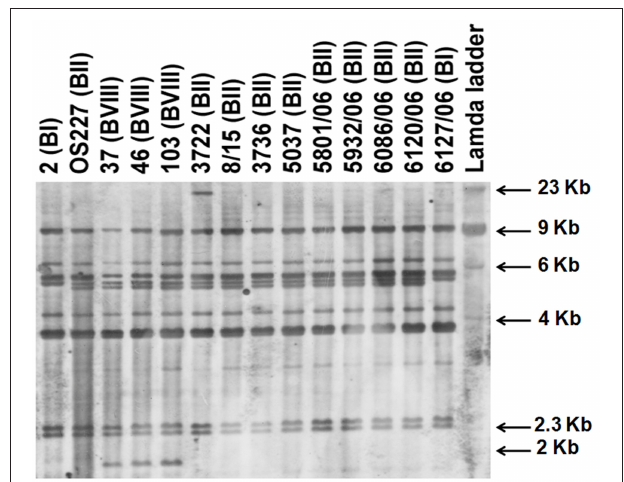
FIGURE 2 | Ribotyping of V. cholerae O139 isolates after digestion of chromosomal DNA with Bgl I. Letter in parentheses against each isolate indicate the ribotype